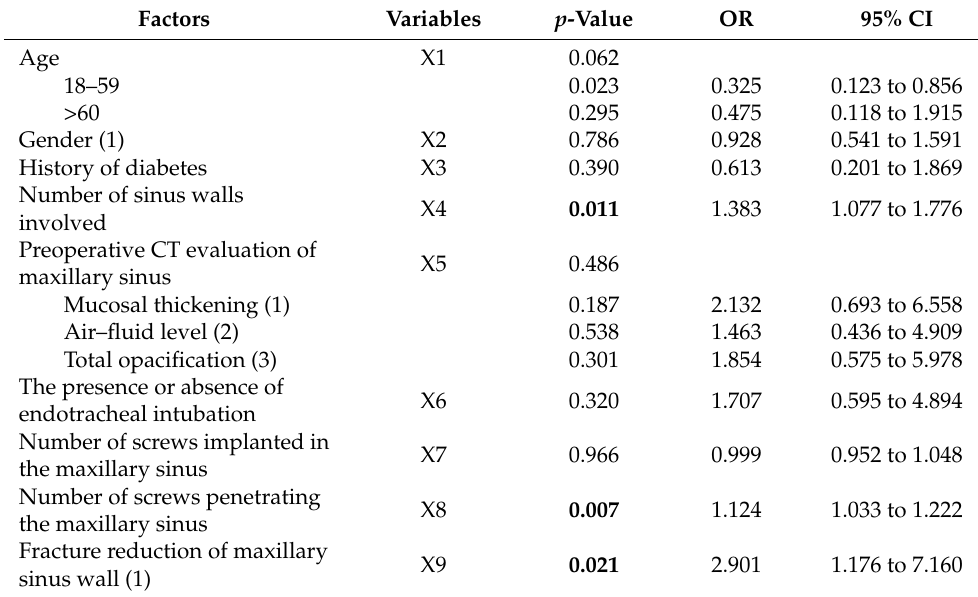
Table 3. Binary logistic regression evaluation of risk factors for post-traumatic maxillary sinus pathology.